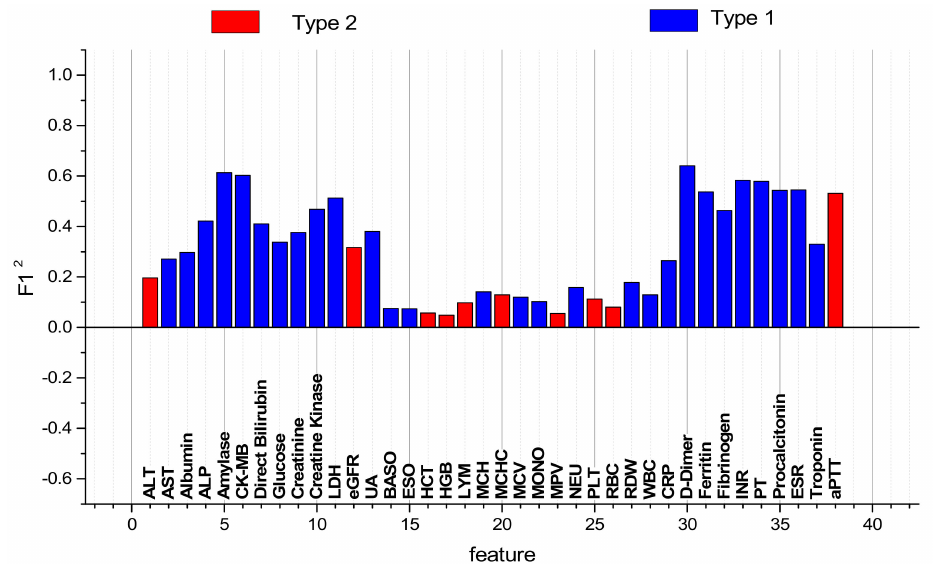
Figure 7. The F1 2 metric for the classification of surviving and non-surviving COVID-19 patients, according to a single feature for the one-threshold approach, with dependency-type visualization (Type 1, Type 2).